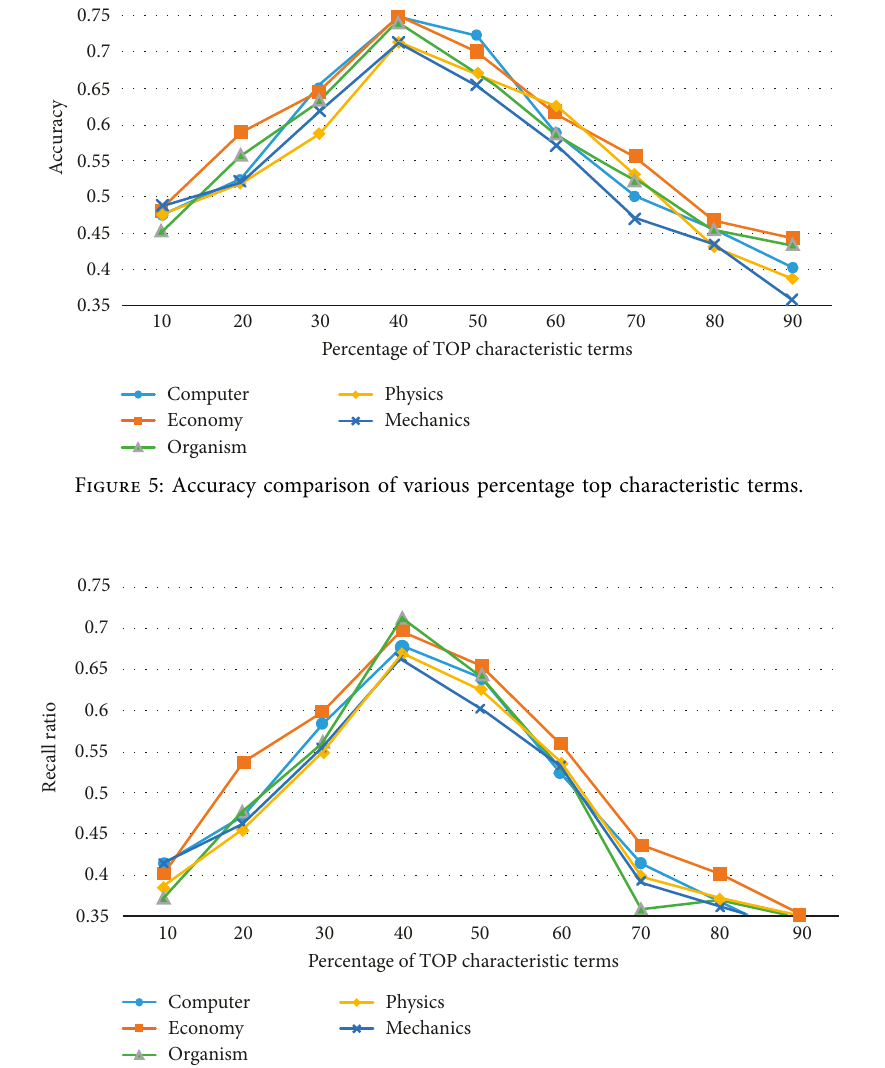
Figure 6: Recall ratio comparison of various percentage top characteristic terms.